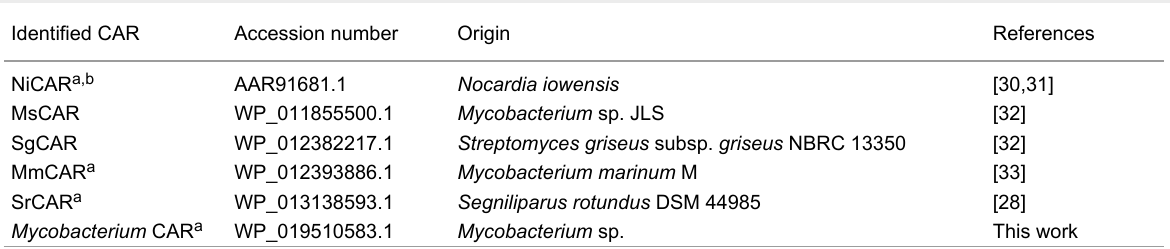
Table 1: Identified CARs (EC